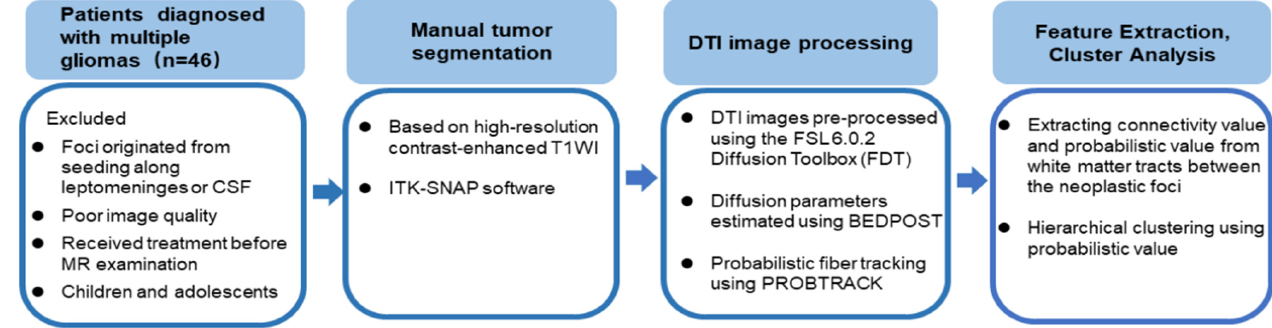
Figure 1. The workflow of probabilistic fiber tracking and cluster analysis. T2WI and FLAIR images of each patient were reviewed by a radiologist (*, with 12 years neuroradiology experience). The presence of a continuous hyperintense